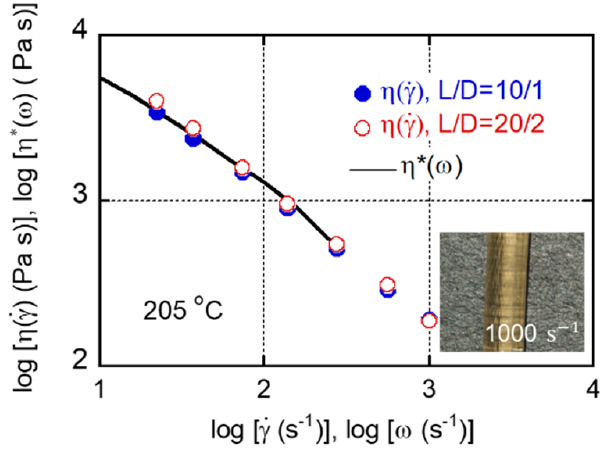
( ) η γ (cid:0) . (cid:1) γ of CA/TEC (60/40) at 205 ◦ C. The photograph shows a  of CA/TEC (60/40) at 205 °C. The photograph shows a ( ) η ω ∗ .